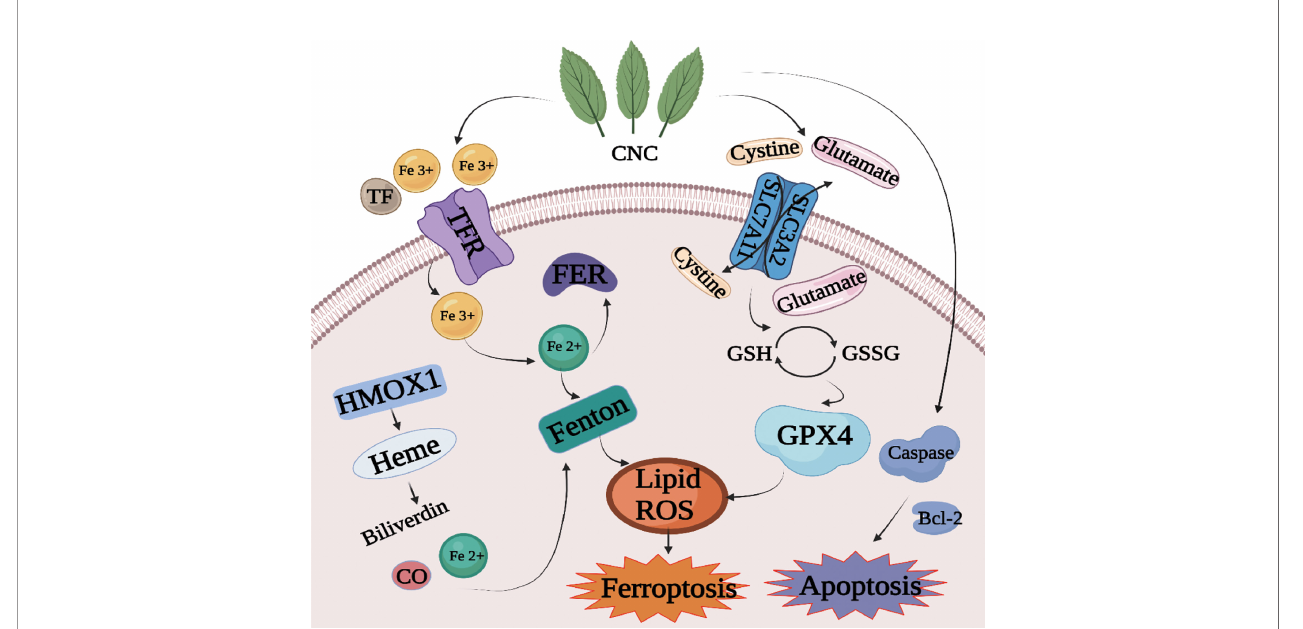
FIGURE 8 | Mechanism diagram of cell death induced by CNC extract through the apoptosis and ferroptosis